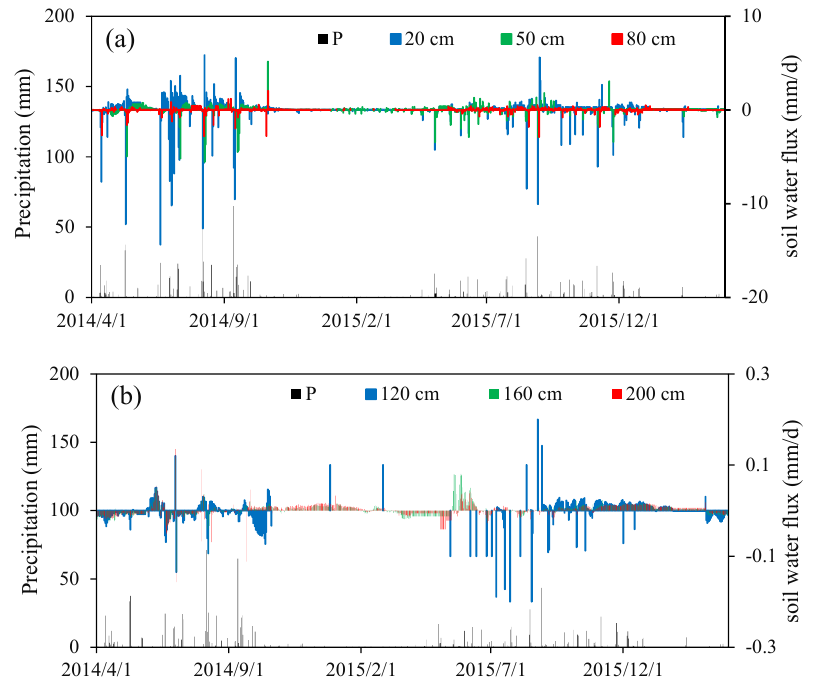
Figure 6. Changes in the soil water flux in the different soil layers and the precipitation distribution: ( a ) variations in the 20 cm, 50 cm, and 80 cm soil layer; and ( b ) variations in the 120 cm, 160 cm, and 200 cm soil layer. Note that the y-axis limits were adapted to the lower values in ( b ). Table 3. The water balance on the plot scale during the modelling period.